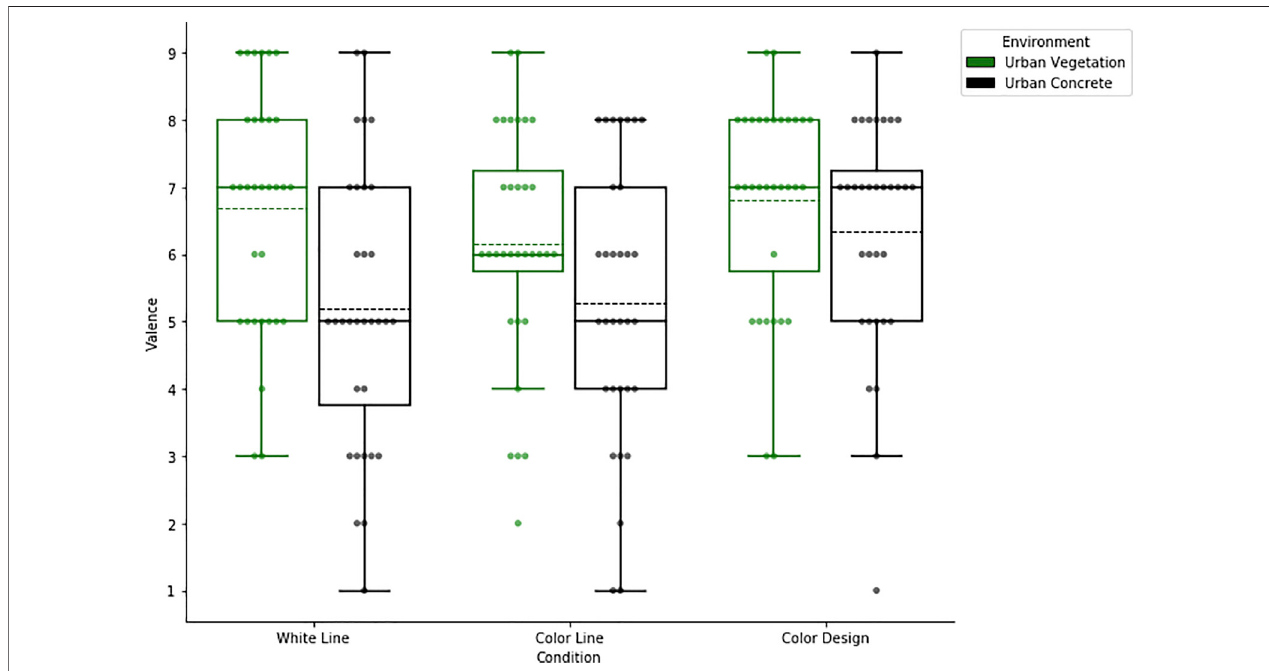
FIGURE 4 | Bar charts illustrating the impact of Environment (Concrete vs . Vegetation) and Condition (White Line; Color Line; Color Design) on the valence dimension of the FAtAAL grid, which reports the perceived pleasure experienced during spontaneous walking in the six different urban virtual environments.